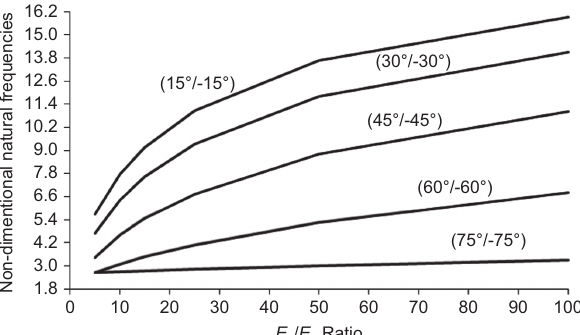
/ E ratio changing with 1 2